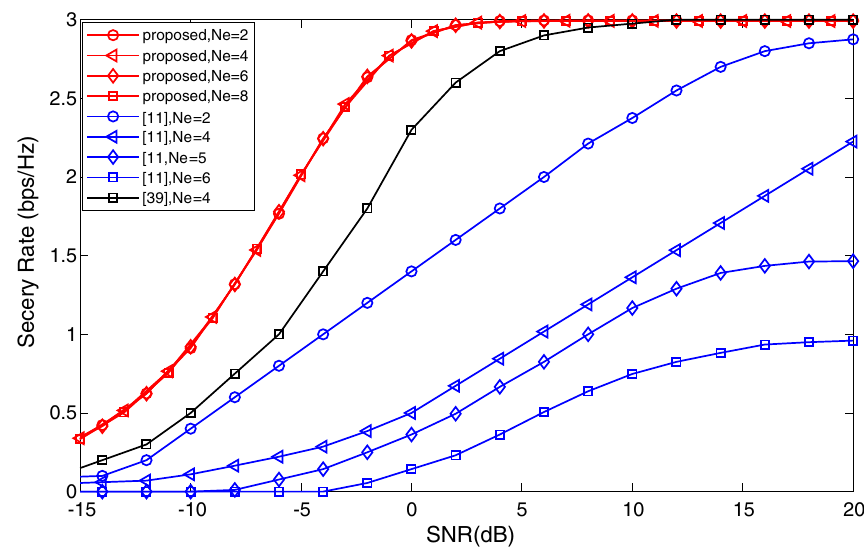
Fig. 11 Secrecy rate comparison with different schemes versus